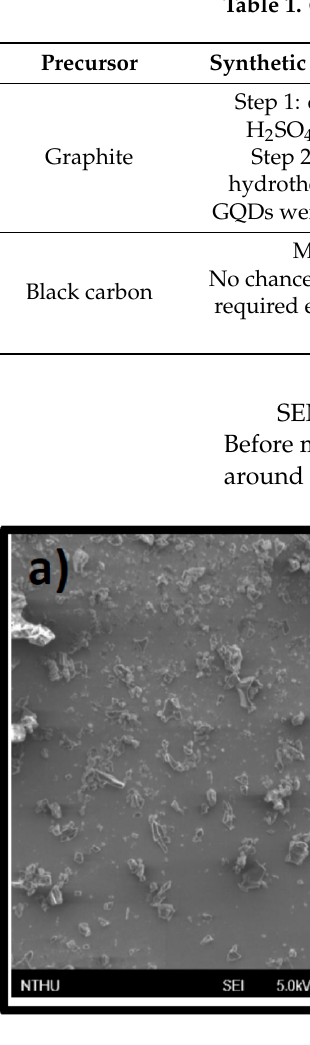
Figure 1. Electron microscope images of BC before microwave irradiation ( a ) SEM. ( b ) TEM. However, following microwave irradiation, GOQD diameters substantially shrank to ~20 nm with extremely thin morphology, as shown in Figure 2a–c. The nano size and thin dot/sphere-like morphology have been demonstrated with low and high magnification images of TEM (Figure 2a,b). The ring-like electron diffraction patterns from Figure 2c represent the poly crystallinity of the GOQDs. The GOQDs’ AFM images in Figure 2d,e reveal the rough topography with dot-like structural features and a size of ~20 nm. This is comparable to the HRTEM results. The height distribution of ~3–6 nm along with some aggregates are seen in Figure 2e (a 3D reconstructed image). The height represents the normal thickness of GO (3 nm) and a few layered GO (6 nm) and indicates that the GOQDs are made of thin graphene GO layers [56]. After morphological and physical structural conformation from electron microscope techniques, FT-IR spectral recordings were used to identify the GOQDs’ chemical function- ality. As seen in Figure 3a, the strong band for aromatic C=C stretching vibration was seen at 1590 cm − 1 , and two other bands for the aromatic C-H out-of-plane deformations were seen between 873 cm − 1 and 753 cm − 1 . Additionally, the existence of the C-O, C-O-C, C-OH, C=O, and -OH groups was indicated by the peaks at approximately 1087 cm − 1 , 1255 cm − 1 , 1381 cm − 1 , 1719 cm − 1 , and 3411 cm − 1 [57]. These oxygen-containing functional groups are an indication of the formation of GOQDs (successful oxidation of BC) and their hydrophilic properties help to keep GOQDs stable in aqueous solutions. Additionally, a faint